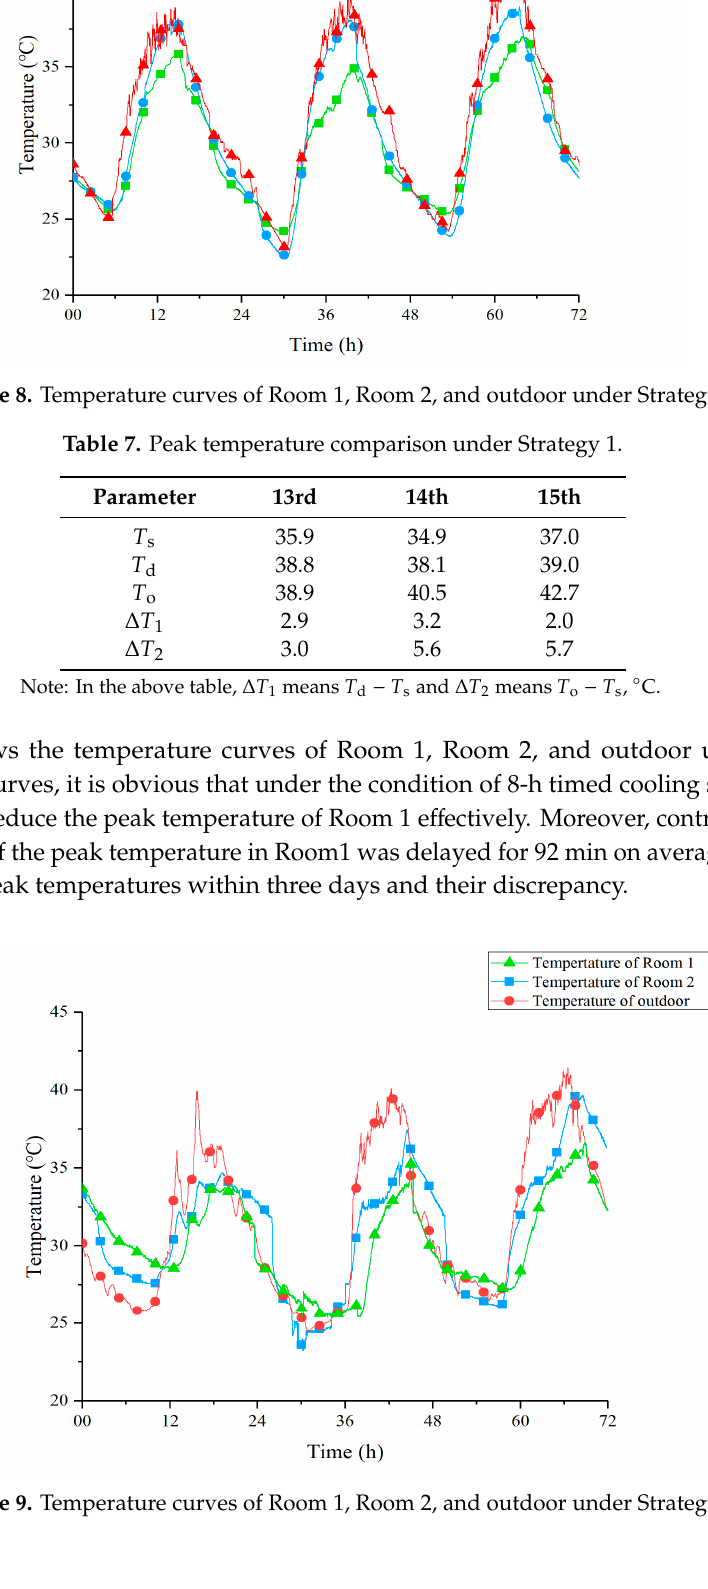
Table 9. Comparison of cooling effect between Strategy 1 and Strategy 2. Strategy